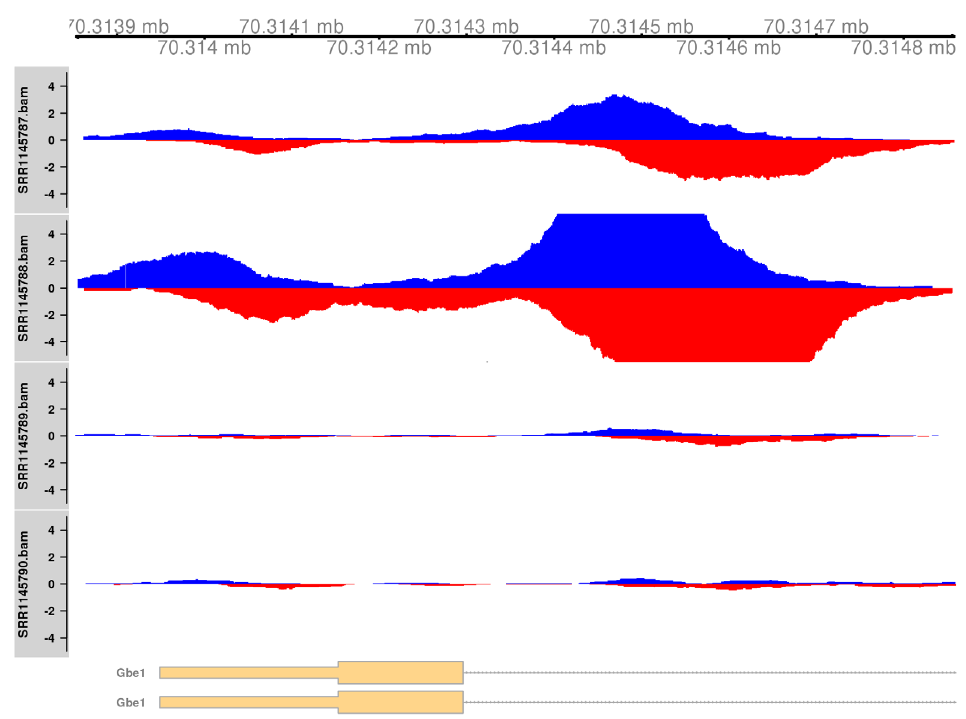
Figure 13. Coverage tracks for TF binding sites that are differentially bound in the WT (top two tracks) against the KO (last two tracks). Blue and red tracks represent forward- and reverse-strand coverage, respectively, on a per-million scale (capped at 5 in SRR1145788, for